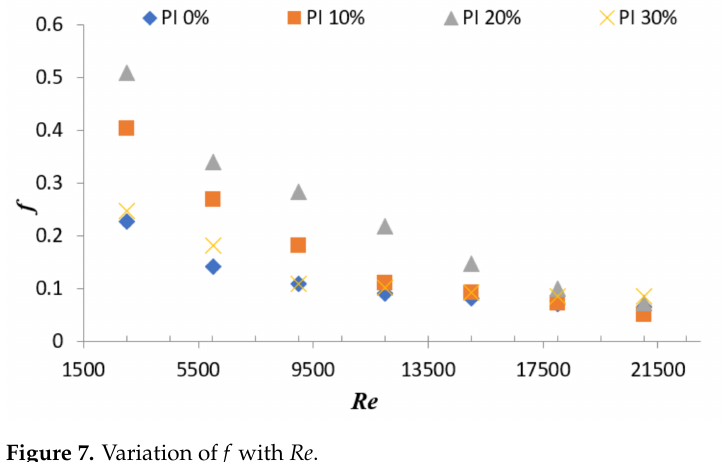
Figure 7. Variation of f with Re .